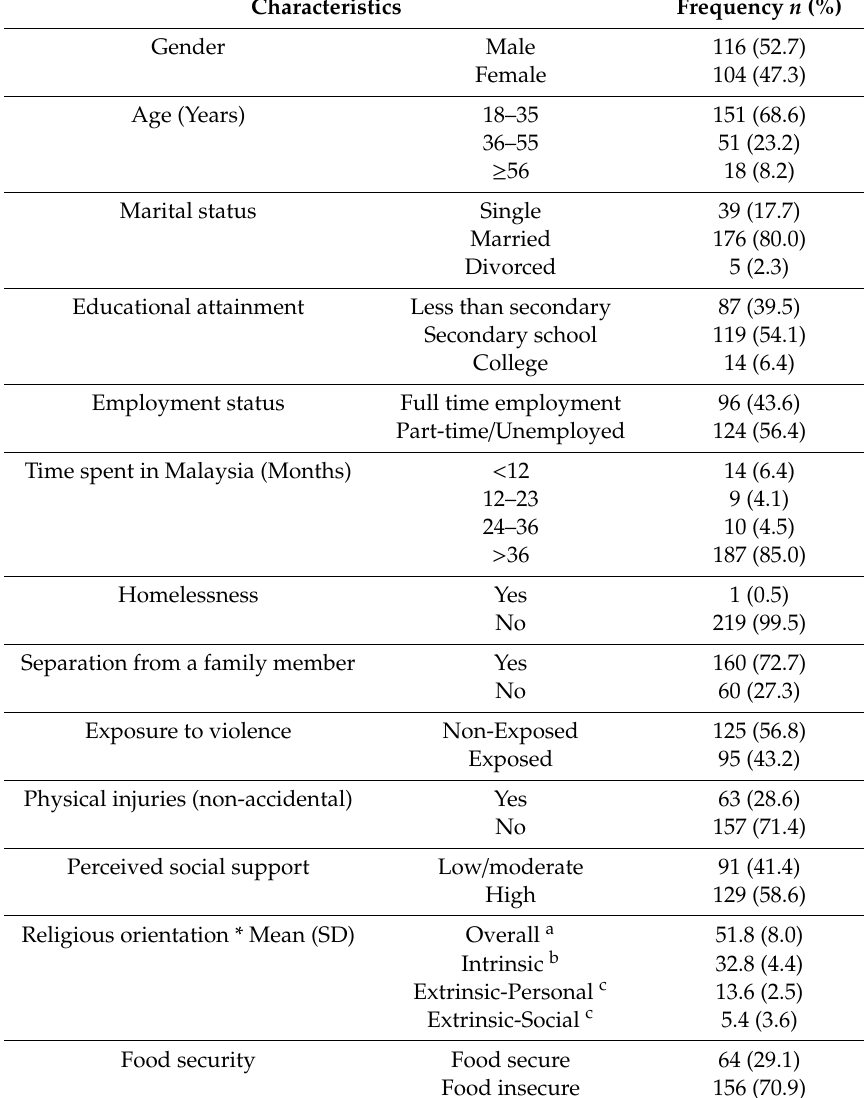
Table 1. Characteristic of participants ( n = 220).